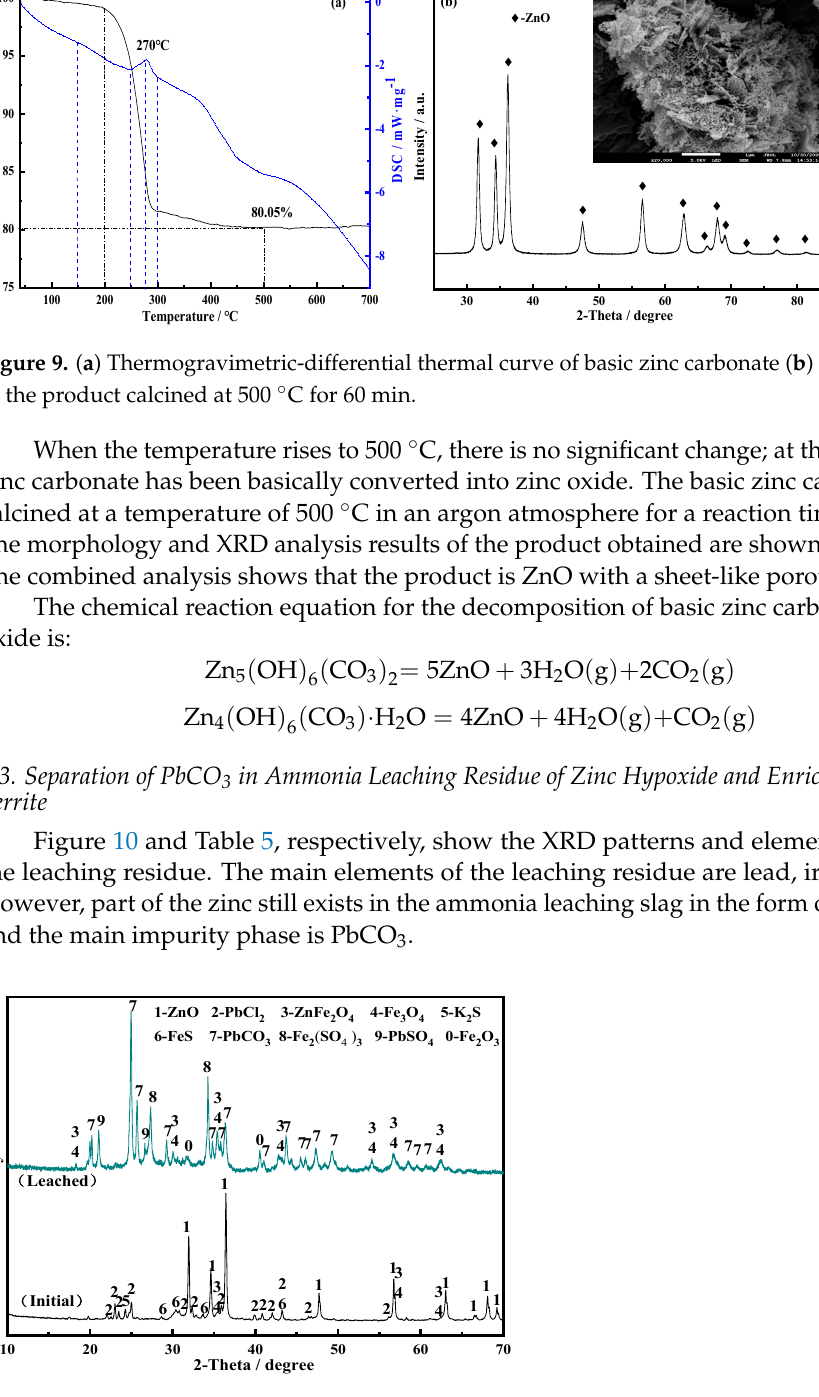
Figure 10. XRD pattern of leaching residue and zinc hypoxide. At the same time, combined with chemical composition analysis, the content of ZnFe 2 O 4 was 42.45% and the content of PbCO 3 was 51.23%, so it is very important to achieve the removal of PbCO 3 . Table 5. Element content in ammonia leaching residue.